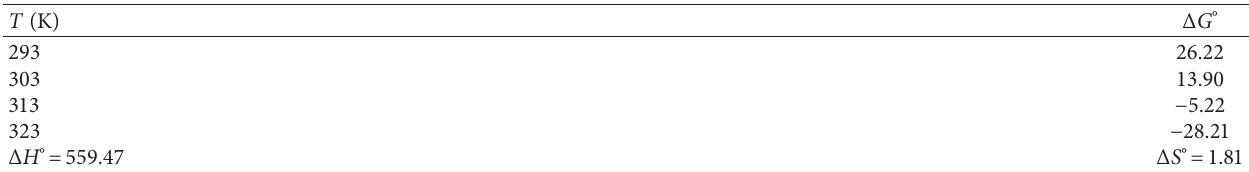
Figure 11: Effect of solution temperature on the percentage removal of TPC and the Langmuir equilibrium constant K Table 5: Thermodynamic parameters of adsorption of TPC onto